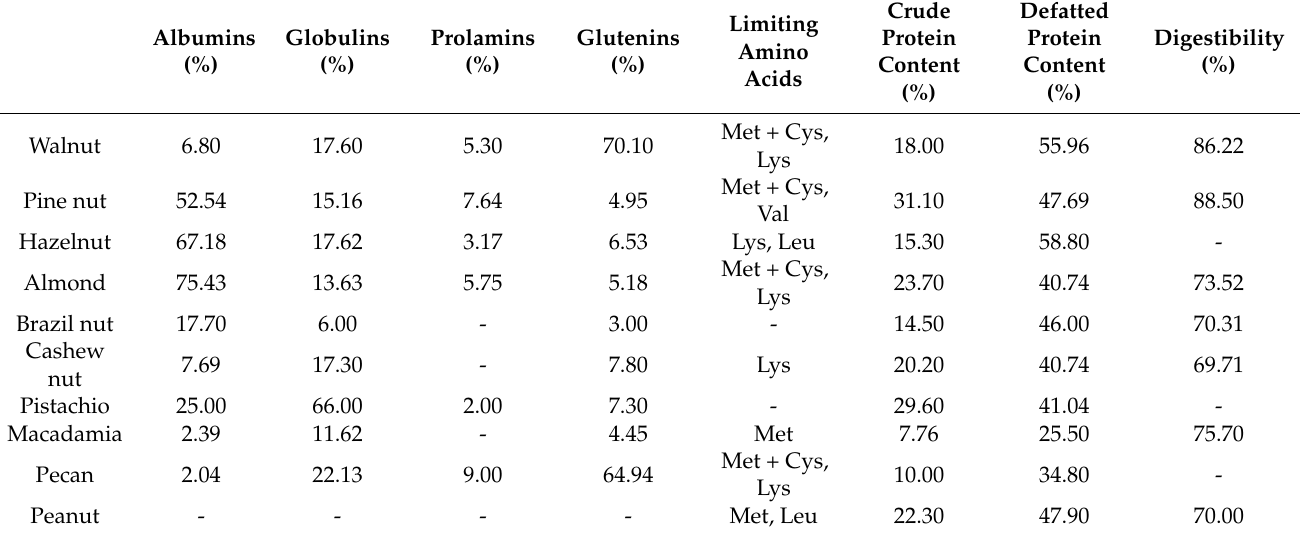
Table 1. Protein fractions, limiting amino acid and digestibility of